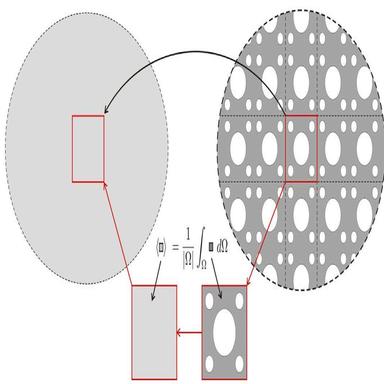
Homogenization of a periodic unit cell.